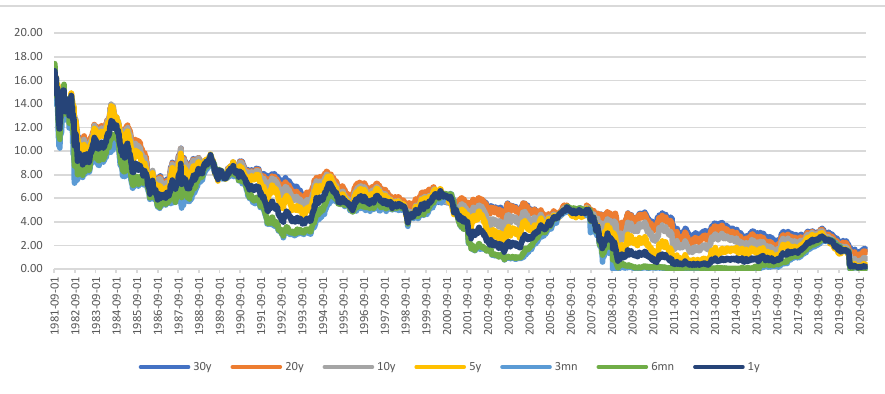
Figure 1. Interest rates for the various maturities. Source: FRED.